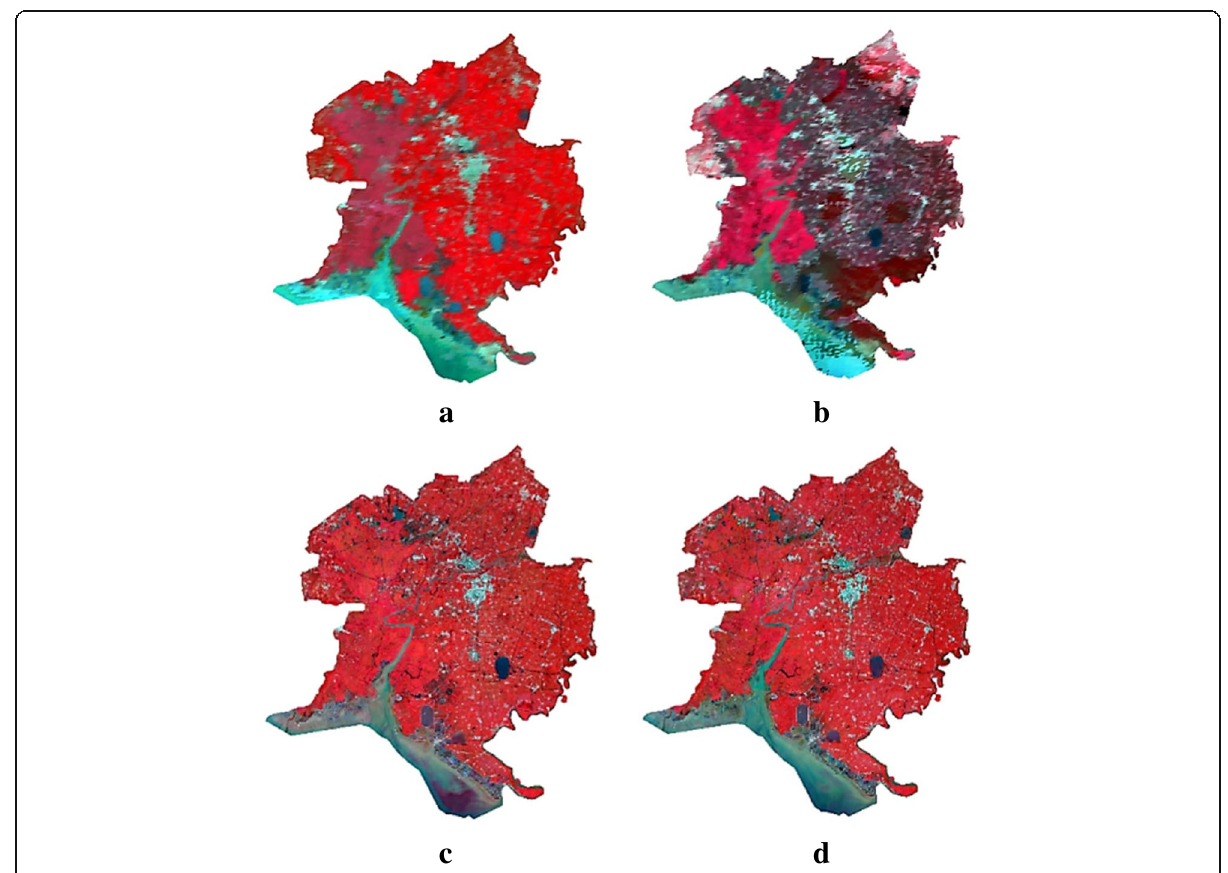
Fig. 5 The false color MODIS image of composite original and merged in Panjin. a Original MODIS images on 18 June 2016. b Original MODIS images on 16 August 2006. c Merged MODIS images on 18 June 2016. d Merged MODIS images on 16 August